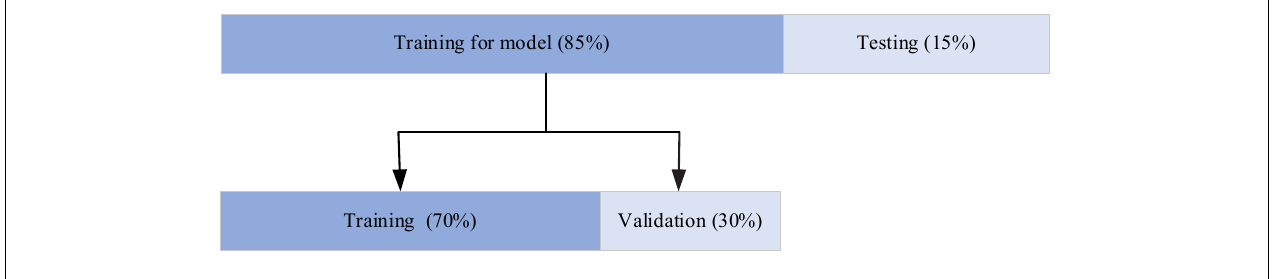
FIGURE 5 | Distribution of the dataset among training, validation, and testing.